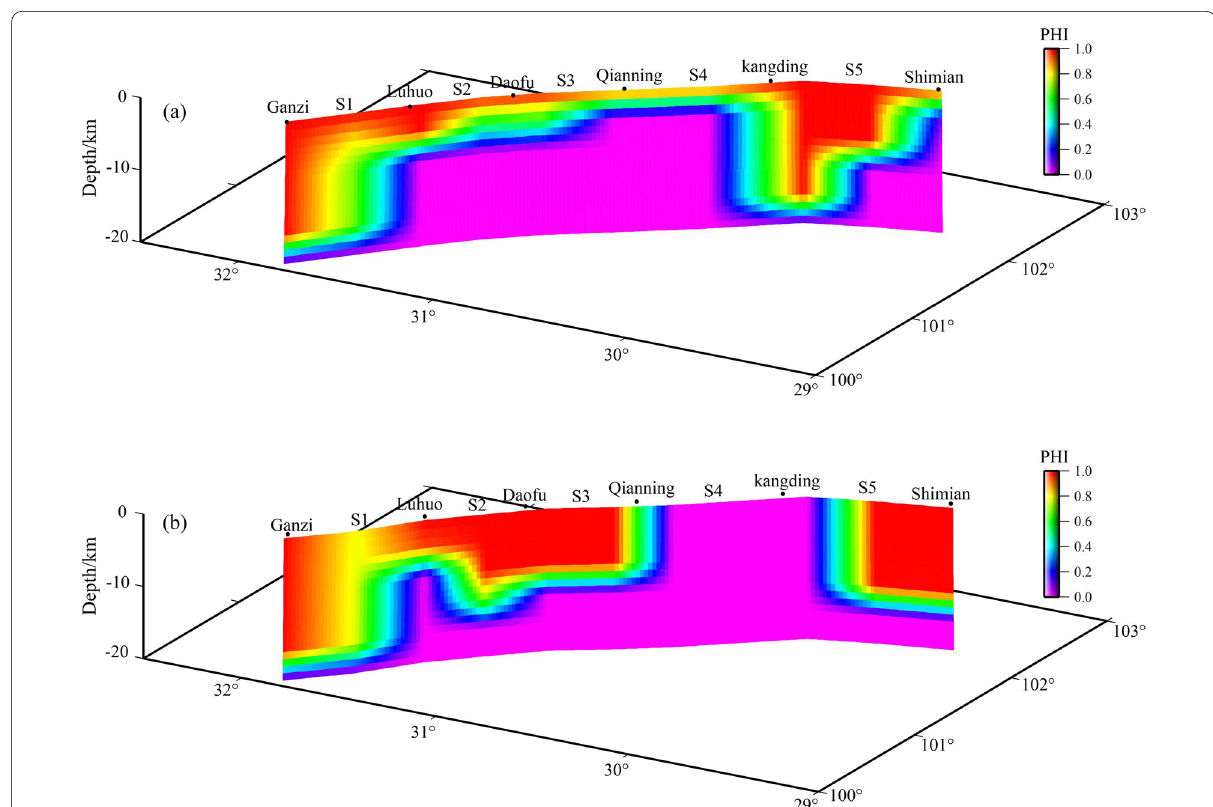
Fig. 8 Locking degree in the Xianshuihe Fault Zone. a and b The locking degrees of the Xianshuihe Fault Zone in 1999–2007 and 2016–2020. S1–S5 represent the Luhuo, Daofu, Qianning, Kangding, and Moxi sections,